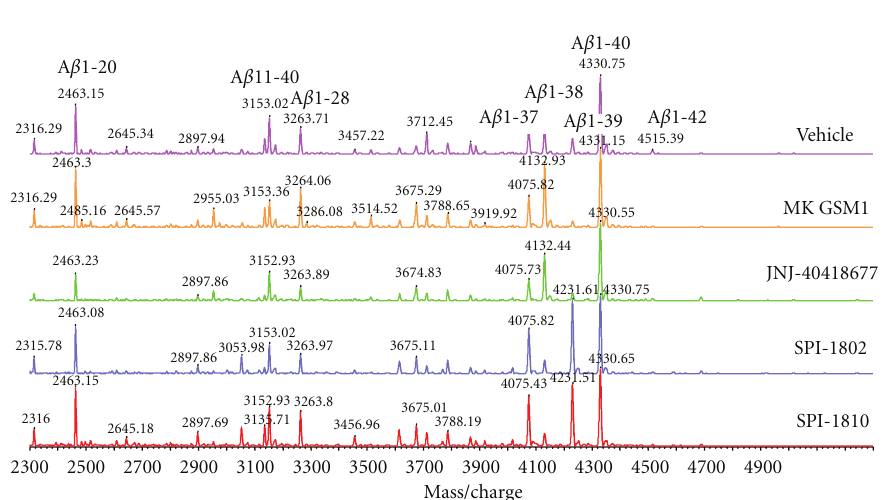
Figure 5: Structures of SPI-1802 and SPI-1810 [20, 37].